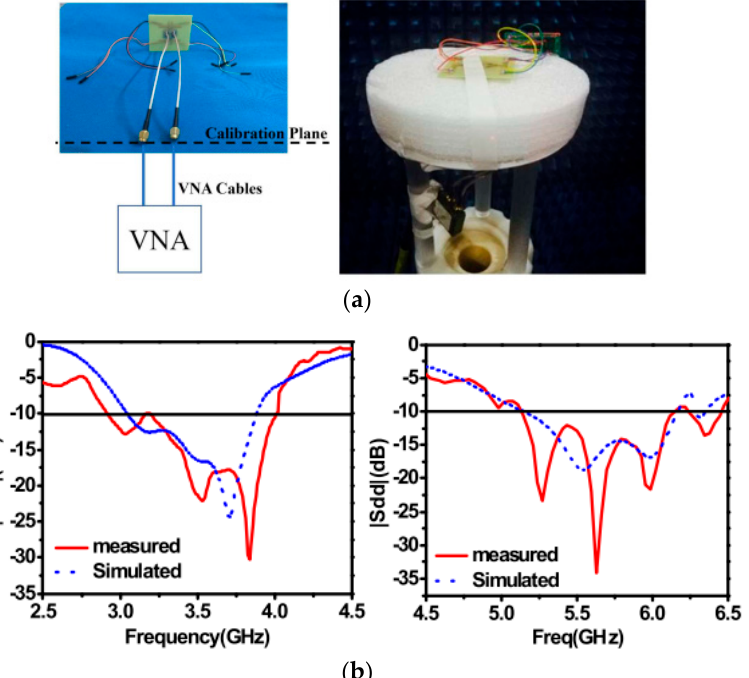
Figure 9. The reconfigurable antenna with the vector network analyzer (VNA) reproduced from [50]. 2020, IEEE: ( a ) prototype structure; ( b ) S-parameter performance for the two states.